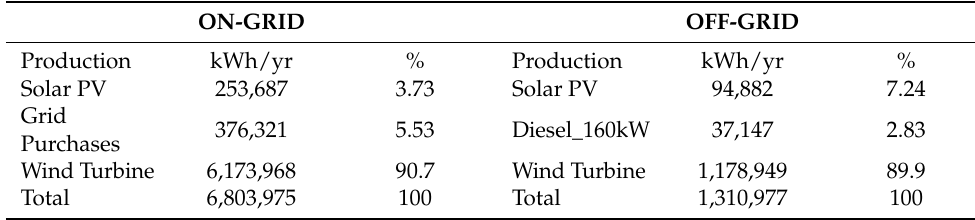
Table 3. Annual electricity